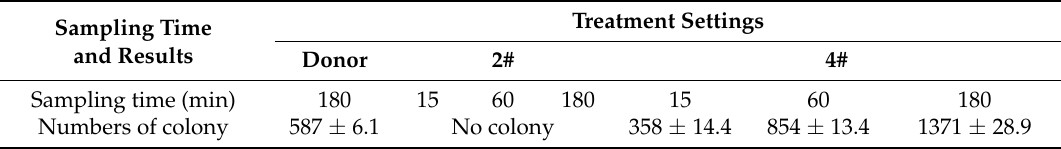
Figure 3. Agarose gel electrophoresis (AGE) of tra F and aph A genes: ( A ) AGE of aph A; ( B ) AGE of tra F; Lane 1–3: samples from recipient flask of Test 1# at 15, 60, and 180 min; Lane 4–6: samples from Test 3# at 15, 60, and 180 min; Lane 7–9: samples from Test 2# at 15, 60, and 180 min; Lane 10–12: samples from test 4# at 15, 60, and 180 min. Table 2. Colony-forming units of cells harboring plasmid RP4